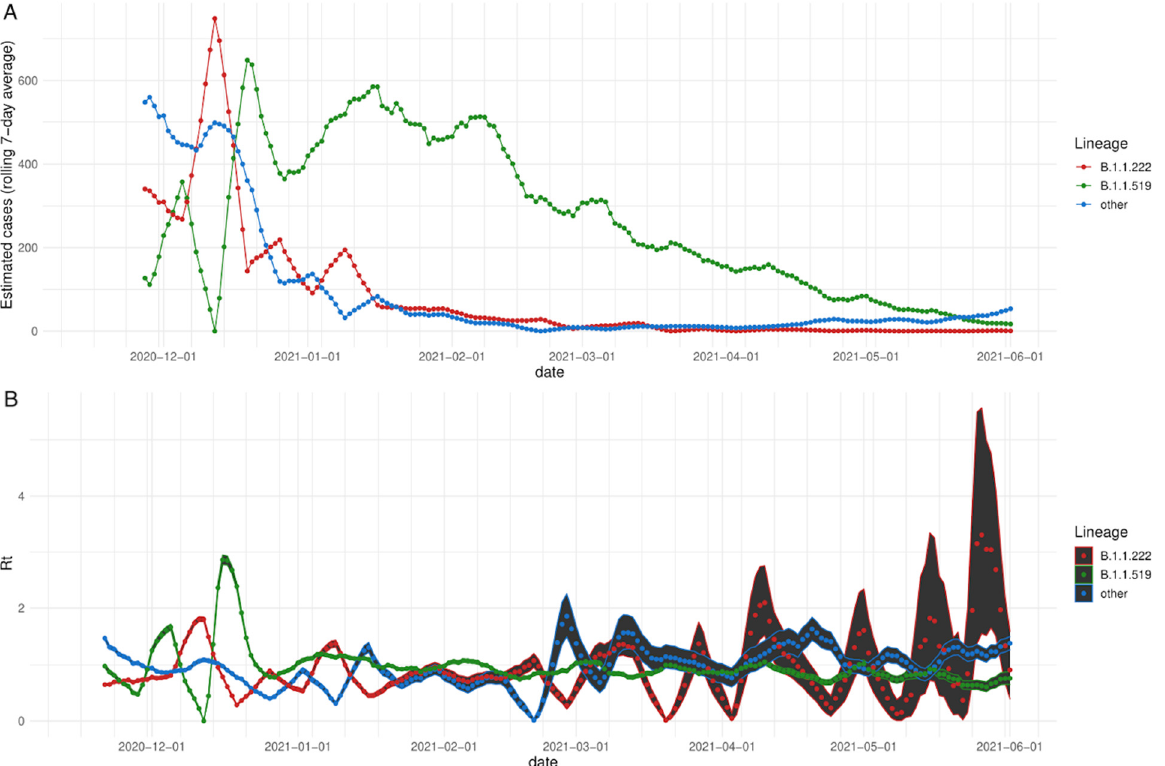
Figure 2. ( A ) Estimated number of cases for each variant based on the frequency observed in sequenced samples at INMG and the daily tally of confirmed cases in SINAVE, 7-day rolling average. ( B ) Time series of estimated Rt. Points represent the mean estimated Rt value per variant. Ribbon boundaries indicate the 5 (lower) and 95 (upper) quantile boundaries of the estimation.